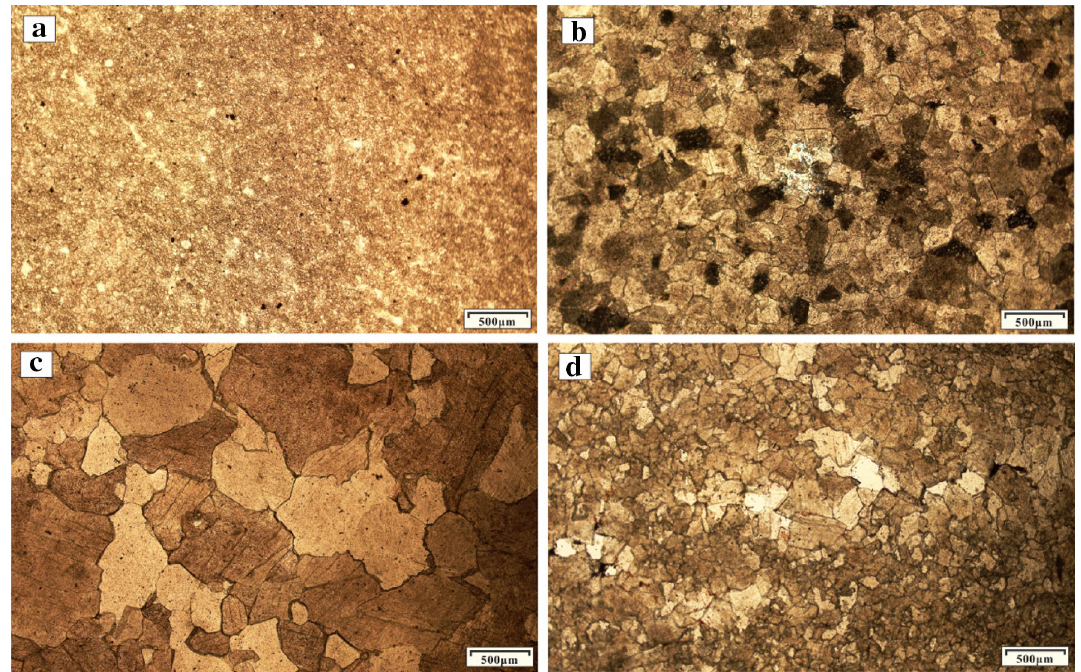
Figure 4. Microphotographs of the Ordovician carbonate crystals (particles): ( a ) Micro-crystalline argillaceous limestones, Well H2, 1089.35 m; ( b ) Medium crystalline dolomites, Well F4, 1456.85 m; ( c ) Coarse crystalline breccia limestones, Well F5, 757.80 m; ( d ) Medium-fine crystalline dolomitic limestones, Well F2, 1134.87 matters (Fig. 5f,g) and silica (Fig. 5g). The Ordovician carbonate rocks with dense dissolution vugs usually show honeycomb textures (Fig. 3a,e,f). The fractures can be divided into structural fractures (Fig. 5i,l), dissolved fractures (Fig. 5b,i,m), and dia- genetic fractures (Fig. 5j,k). (1) Structural fractures. The multi-stage tectonic activities formed two types of structural fractures: one is high angle tensile fractures formed by region stress release, and the other is associated with fault activity and mainly distributed on both sides of the fault zones and in the axial portion of the folds (Fig. 1c,d). According to the stratigraphic occurrence (near E-W striking and dip angle 0° –20°) and fracture characteristics, the structural fractures in the study area can be subdivided into bedding fractures (dip angle full-filled with calcites and/or quartz (Fig. 5i,m). The width of high-angle and vertical fractures are 0.1 mm–5 cm, unfilled (Fig. 5i) or semi-filled with calcites, muds, and/or hydrothermal minerals (Fig. 5l). (2) Dissolved frac- tures. The dissolved fractures were formed by infiltration and dissolution of aggressive fluids (atmospheric water or hydrothermal fluids) along with the structural fracture system, irregular and uneven fracture surface. Meteoric water and hydrothermal fluids directly infiltrate along micro-cracks, infiltration of calcites, muds, hydrother- mal minerals, and so on, which can be seen in the fractures (Fig. 5b,i,m). (3) Diagenetic fractures. Diagenetic fractures are cracks formed from sedimentation to consolidation diagenesis. The shrinkage crack, whose width is generally at the micron scale, formed at the early diagenetic stage with irregularly networked and often filled with calcites (Fig. 5j). Stylolites are the result of the selective dissolution of mineral particles, which is caused by the combined action of overburden pressure and pore fluid under deep burial conditions. Stylolites are mainly formed by horizontally stretching, and usually filled with muds and/or organic matters (Fig. 5k). The dissolution channels are solution-enlarged fractures and may be the result of dissolution. They are often observed around tectonic fractures, faults, bedding planes or unconformities, which may be the result of dis- solution and expansion of fractures 24 . The opening of the channels ranges from tens of millimeters (Fig. 5f) to several meters (Fig. 6a,b), and the lengths range from several centimeters (Fig. 5f) to several meters (Fig. 6a,b). In underground burial areas, channels are usually semi-filled or full-filled with karst breccias (Fig. 5h) and/or muds and/or calcites (Fig. 5f); while in surface outcrops, channels are usually unfilled or semi-filled with the Quaternary loose sediments, thereby forming surface subsidence ditches (Fig. 6a,b). The caves are primarily developed around the Ordovician paleoweathering crust (Fig. 7a) and faults and fold zones (Fig. 1c), and their sizes vary from a few centimeters to a dozen meters (Fig. 7a). The outcrops and exploration wells show that the cavity fillings and filling patterns are complicated and diversified. Caves in the paleoweathering crust are generally developed within 30 m below the Ordovician unconformities. They are usually filled and cemented by collapse breccias and gray-green muds (Fig. 7b,c,d). Seen from exploration data, caves are usually found near the fault and fold zones (Fig. 1c), and they are generally unfilled or semi-filled with broken surrounding rocks, and sometimes collapse breccias and calcites as well. The obvious blowdown and leakage phenomenon in the drilling process are an important symbol of caves.